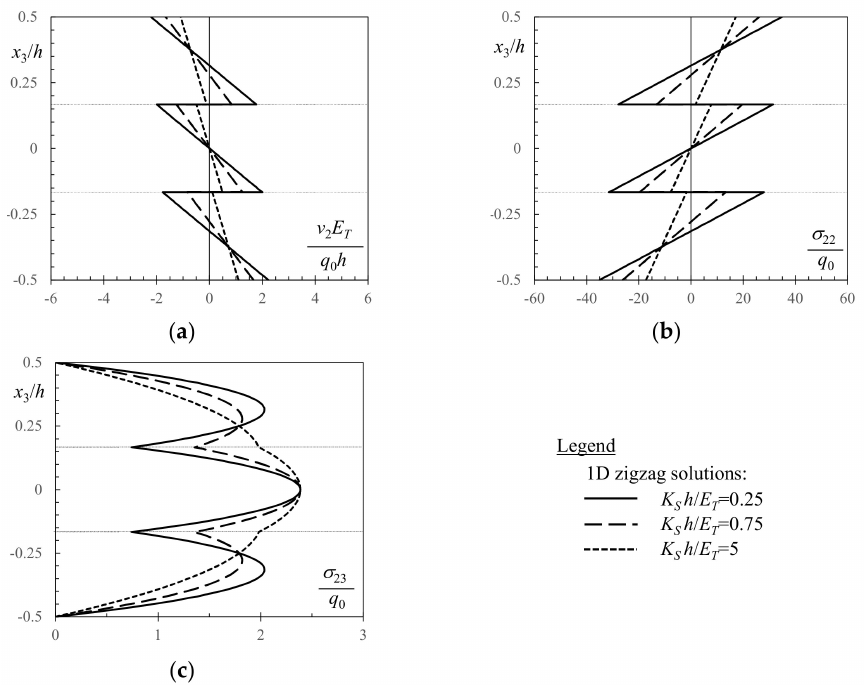
Figure 7. 1D zigzag solutions for simply supported three-layer beam (0 ◦ /0 ◦ /0 ◦ ) with L / h = 5 having interfaces of equal stiffness and subjected to sinusoidal transverse load: ( a ) local longitudinal displacements (at x 2 = 0); ( b ) bending stresses (at x 2 = 0.5 L ); ( c ) transverse shear stresses (at x 2 = 0) determined from local